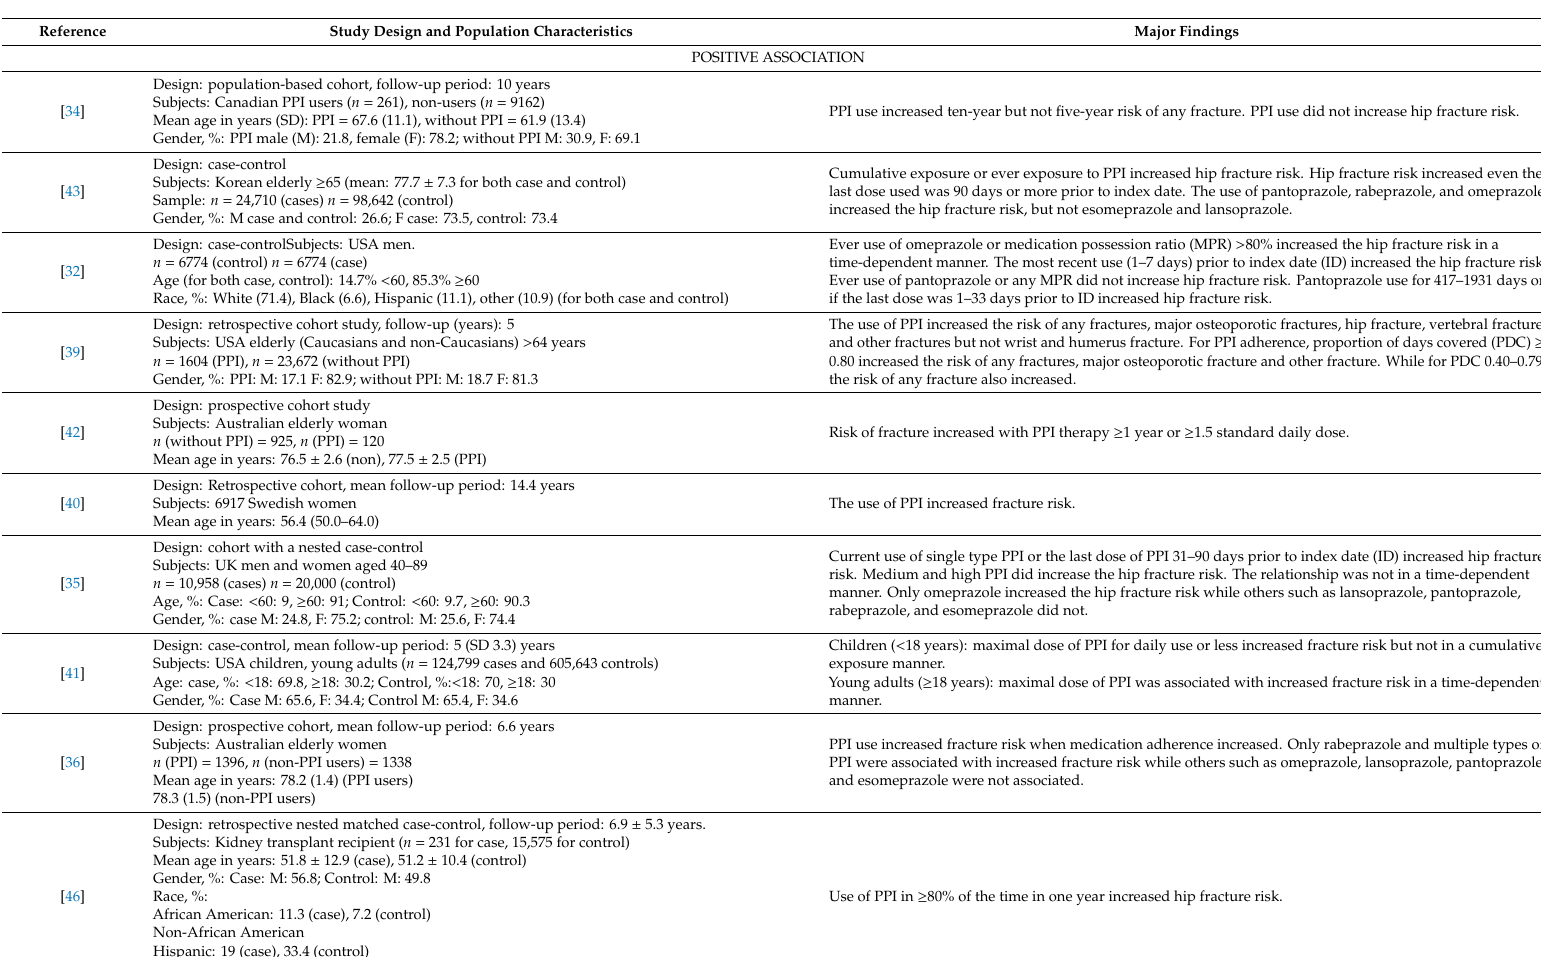
Table 1. Summary of epidemiological studies. PPI—proton pump inhibitor; USA—United States if America; UK—United Kingdom; GERD—gastroesophageal reflux